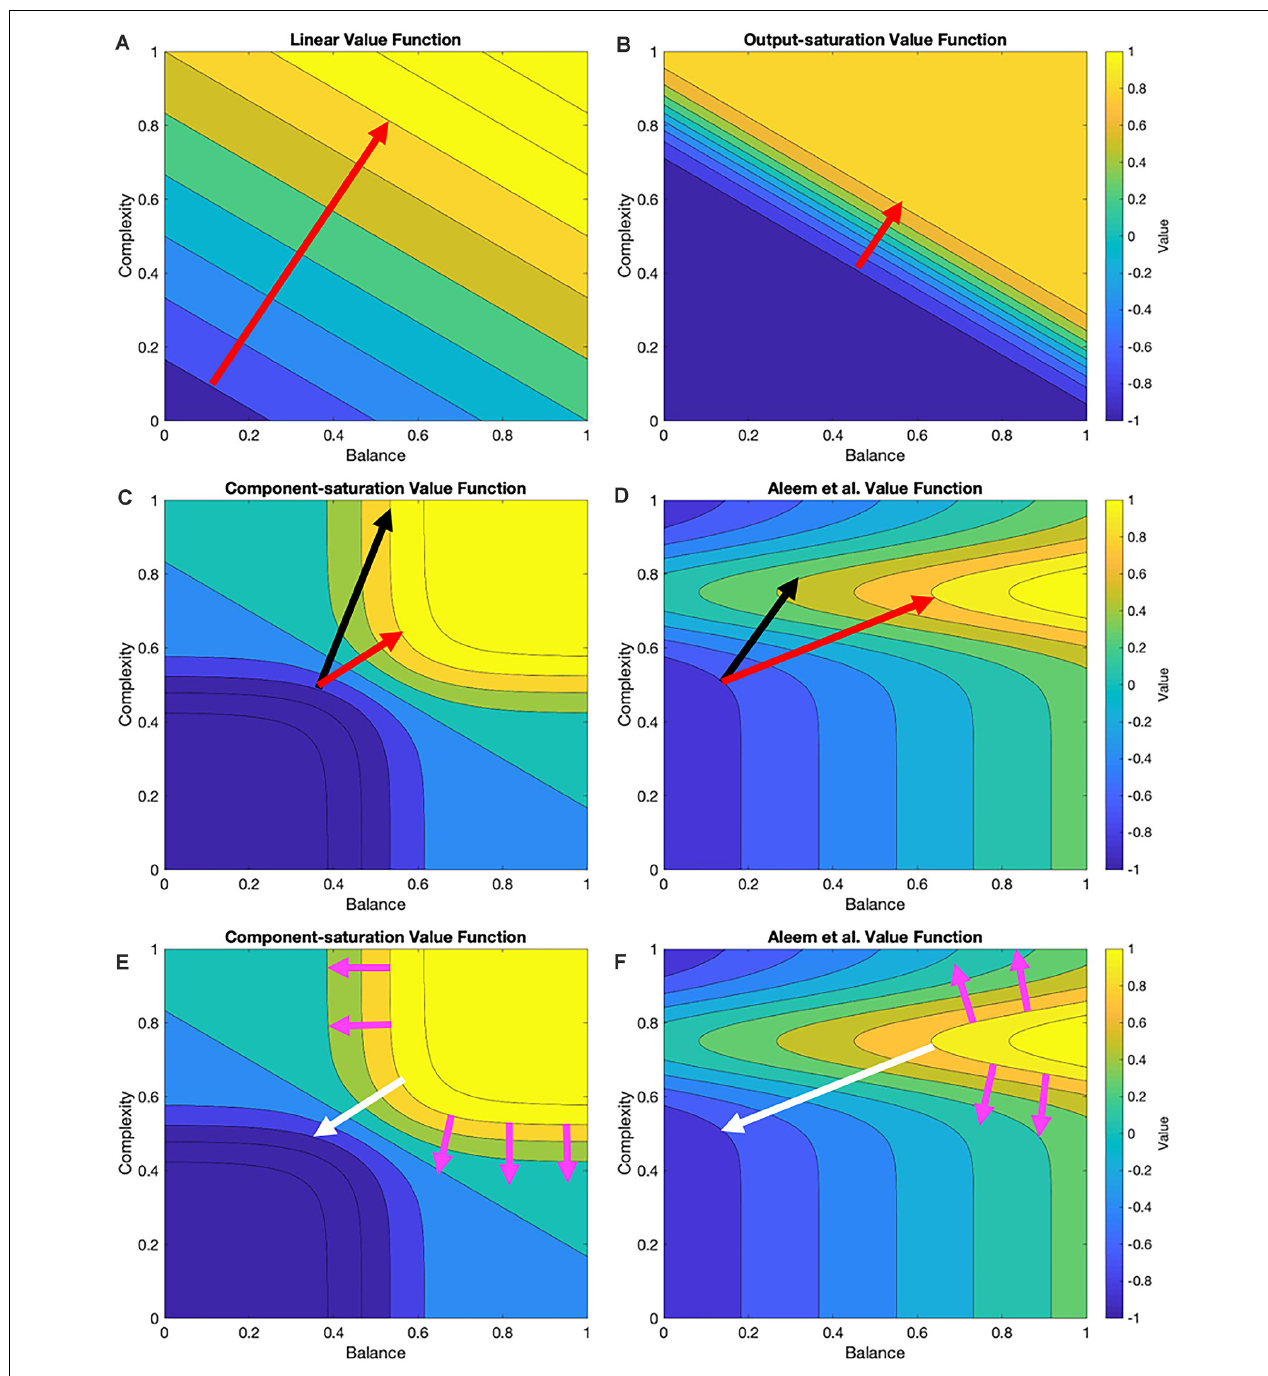
FIGURE 1 | Contour plots of four examples of value functions and relationships to possible update rules. These value functions are two-dimensional in this research (“Stochastic Sampling” section) but multi-dimensional in general. In the examples given here, the two dimensions are measures of balance and complexity in visual images. These measures range from 0 to 1 for the value functions illustrated in this research. The parameters of the value functions are those of Table 2 . The red arrows indicate the optimal trajectory from the current position of the vector of free parameters of the value function to the closest point of the isoline corresponding to the sampled reward (Here, we call this curve the target isoline, but in general, it is an isosurface.) The black arrows indicate the trajectory based on gradient computation. (A,B) For the Linear and Output-saturation value functions, the gradient and optimal trajectories coincide. (C,D) For the Component-saturation and Aleem et al. models, the gradient trajectory is not optimal. (E,F) However, if one computed the gradients from the target isoline instead of the current position (magenta and white arrows), the gradient at the optimal point on the target isoline would be parallel to the optimal trajectory (“Results” section; white arrows). We call this computation the Shortest-path or Phi rule (“Update Rules for Value Functions”